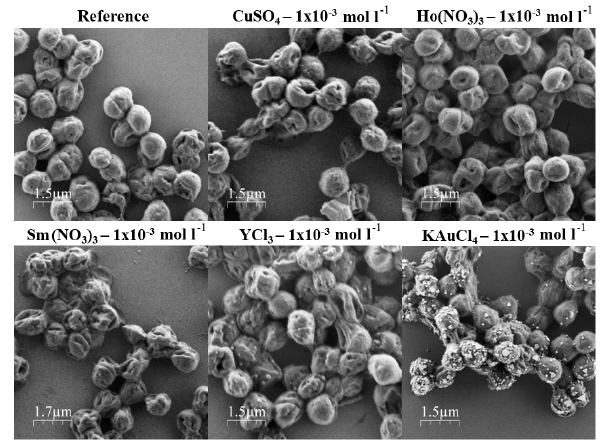
Figure 3. SEM images from S. ureae ATCC 13881 cells from the metal binding test after 2 days’ incubation with 1 × 10 − 3 molL − 1 CuSO 4 , Ho(NO 3 ) 3 , Sm(NO 3 ) 3 , YCl 3 and KAuCl 4 solutions.